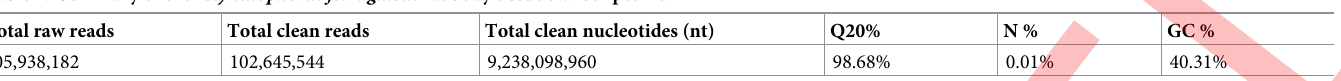
Table 2. Summary of the Rhynchophorus ferrugineus fat body tissue transcriptome. Total raw reads